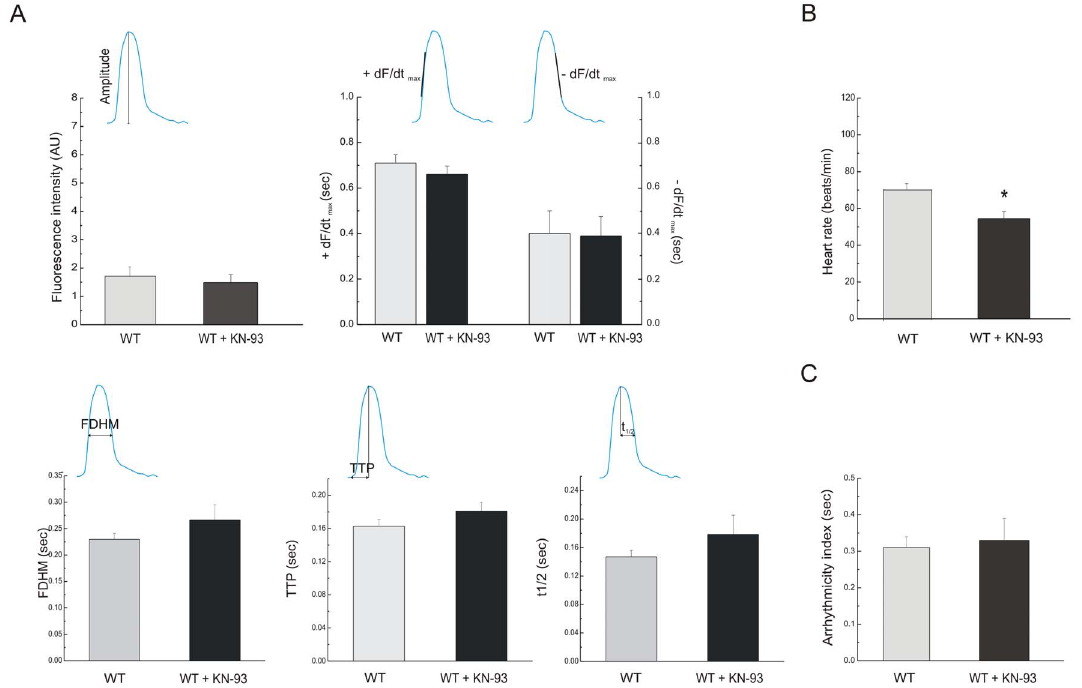
Figure 5. Inhibition of CaMKII with KN-93 affects the spontaneous frequency of the heart. A. Flies of 7 days treated with 5 m M KN-93 did not exhibit changes of fluorescence intensity (top, left graph), + dF/dt max , 2 dF/dt max (top, right graph), FDHM (bottom, left graph), TTP (bottom, middle graph) neither t 1/2 (bottom, right graph) compared whit the same 7 days flies previously observed without incubated with the CaMKII inhibitor. B. Inhibition of CaMKII reduced spontaneous heart rate without changes of the arrhythmicity index. Mean 6 SEM of 24 flies. *p # 0.05.